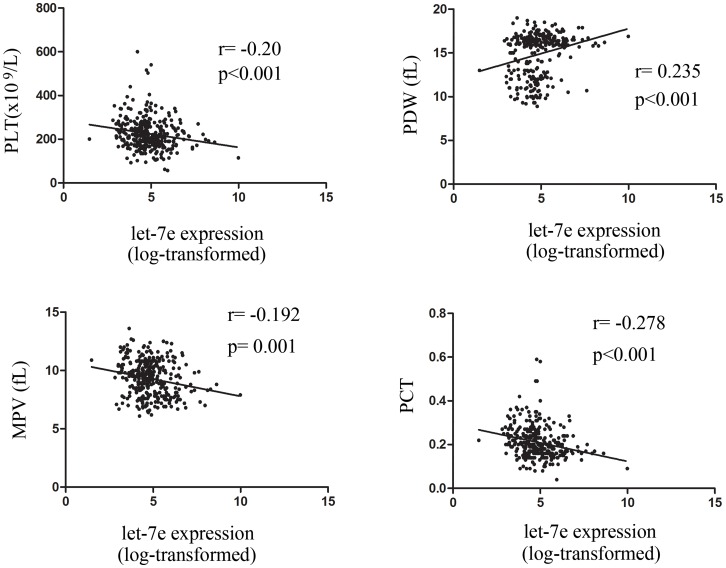
Correlations between let-7e-5p expression and platelet parameters.The correlation was evaluated by the Spearman test in the combined patient population.